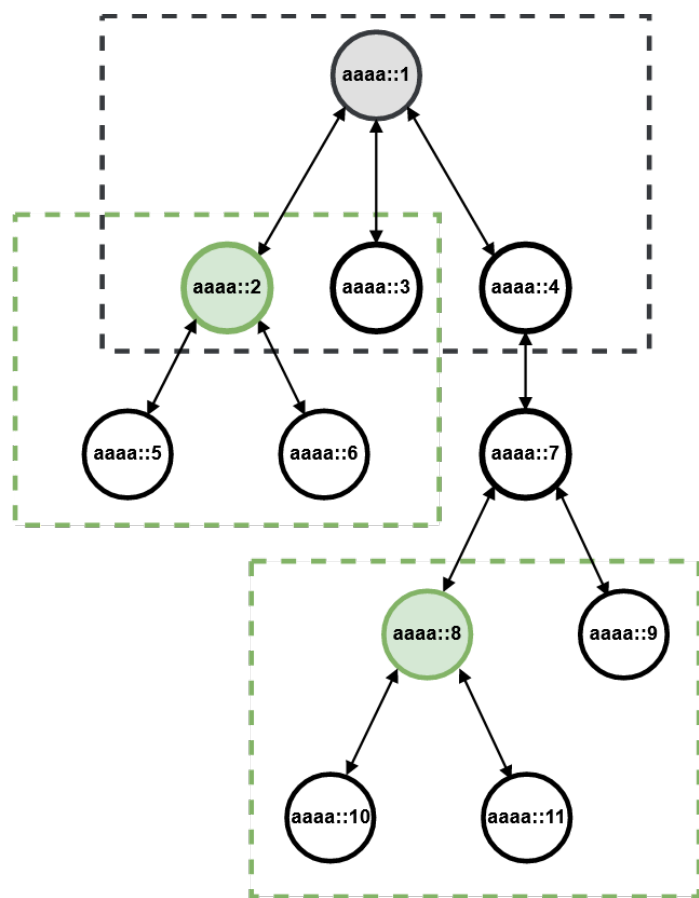
Figure 1. Hybrid IDS design example. The shaded node (aaaa::1) is the root, and it hosts the central IDS. The doted rectangle in black represents the nodes in TX/RX range from the root node. Nodes in green (aaaa::2 and aaaa::8) represent IDS detectors. The doted rectangle in green represents the nodes in TX/RX range from the IDS detector